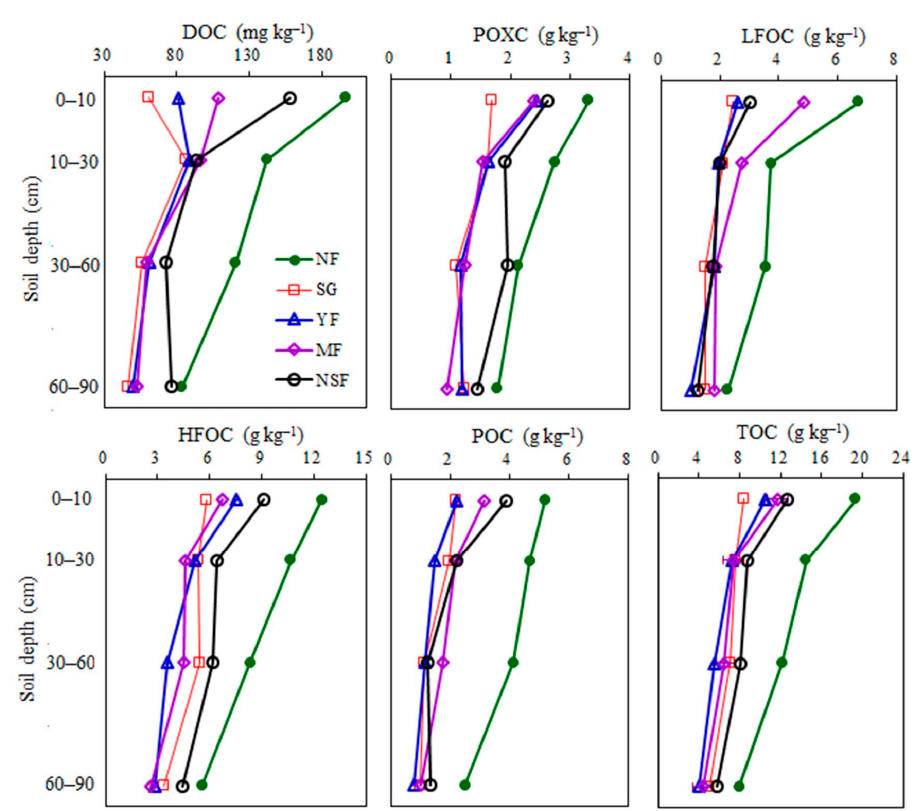
Figure 4. Distributions of soil total organic carbon (TOC) and carbon fraction concentrations for five vegetation types. DOC, dissolved organic carbon; LFOC, light fraction organic carbon; HFOC, heavy fraction organic carbon; POXC, permanganate oxidizable carbon; POC, particulate organic carbon. NF, natural forest; SG, shrub-grass land; PF, coniferous Pinus forest; MF: coniferous and broad-leaved mixed forest; NSF, natural secondary forest. Table 1. Results of two-way ANOVA of the single and interactive effects of soil depths and vegeta- tion types on soil organic carbon, carbon fractions, and the sensitivity indices of the soil carbon indices.